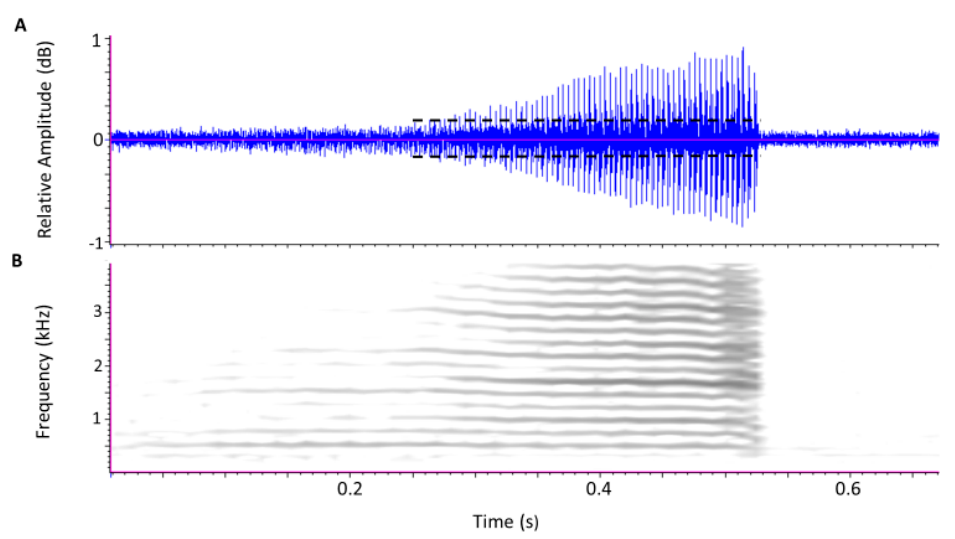
Figure 1. Oscillogram ( A) and spectrogram ( B ) of a 0.28 s, D. citri vibrational call. Dashed lines indicate the threshold amplitude for background noise, above which the signal analyzer program checks for the presence of wingbeat pulses. Darker shades in the spectrogram (1024 point spectrum width) indicate greater energy at the specified time and frequency. The ca. 250 Hz wingbeats appear as closely spaced signal pulses in the oscillogram and display multiple harmonics of 250 Hz in the spectrogram (1024 point spectrum width).